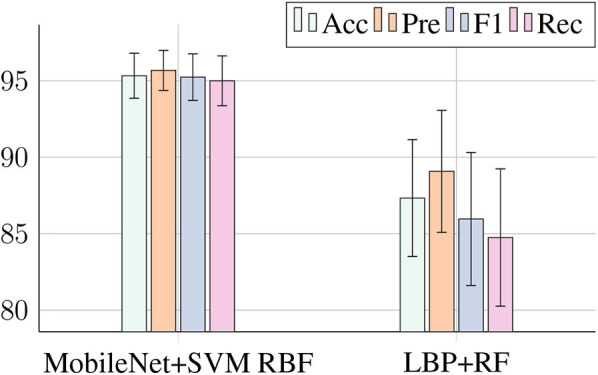
A plot representation of the best metrics from Tables 2–4.